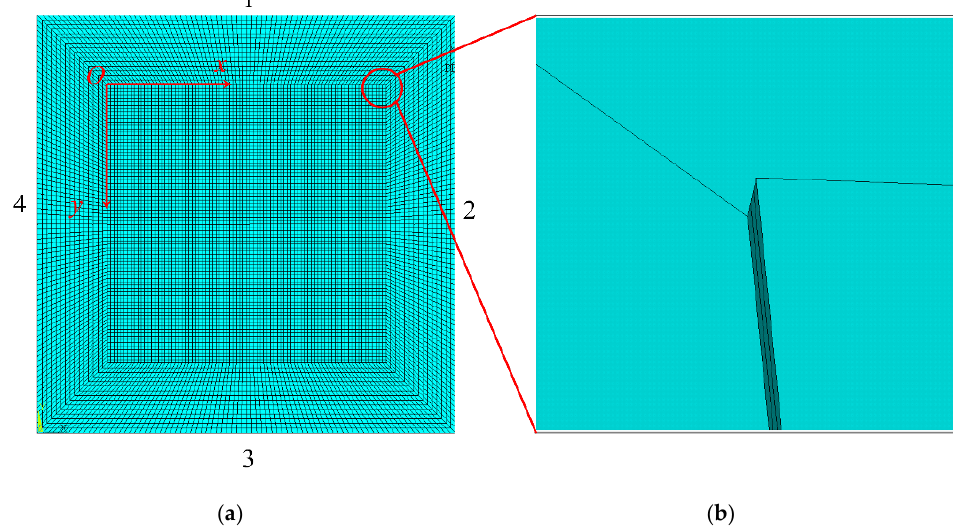
Figure 3. Finite element model diagram: ( a ) overall model and ( b ) local detail model.